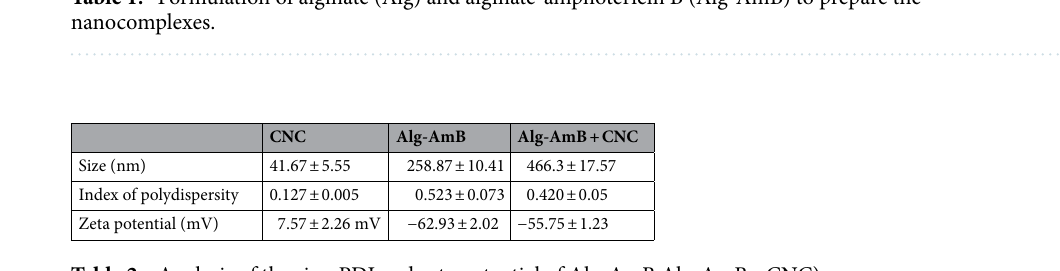
Table 2. Analysis of the size, PDI and zeta potential of Alg-AmB Alg-AmB +